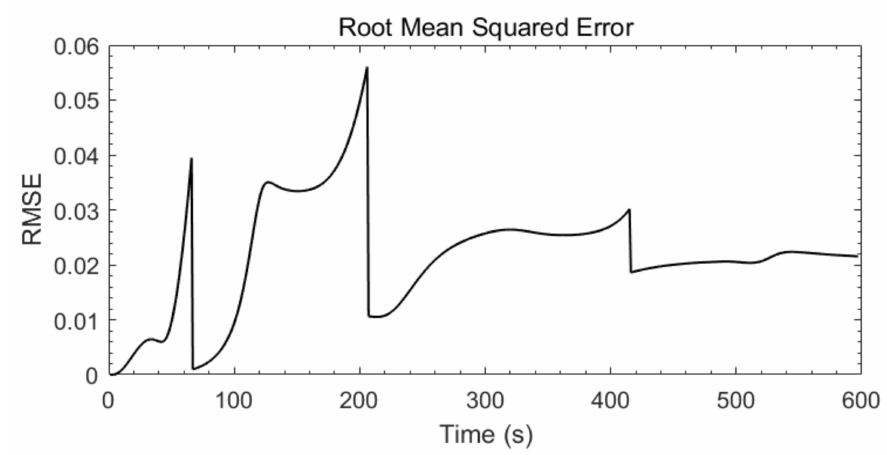
Figure 18. Output error in training.